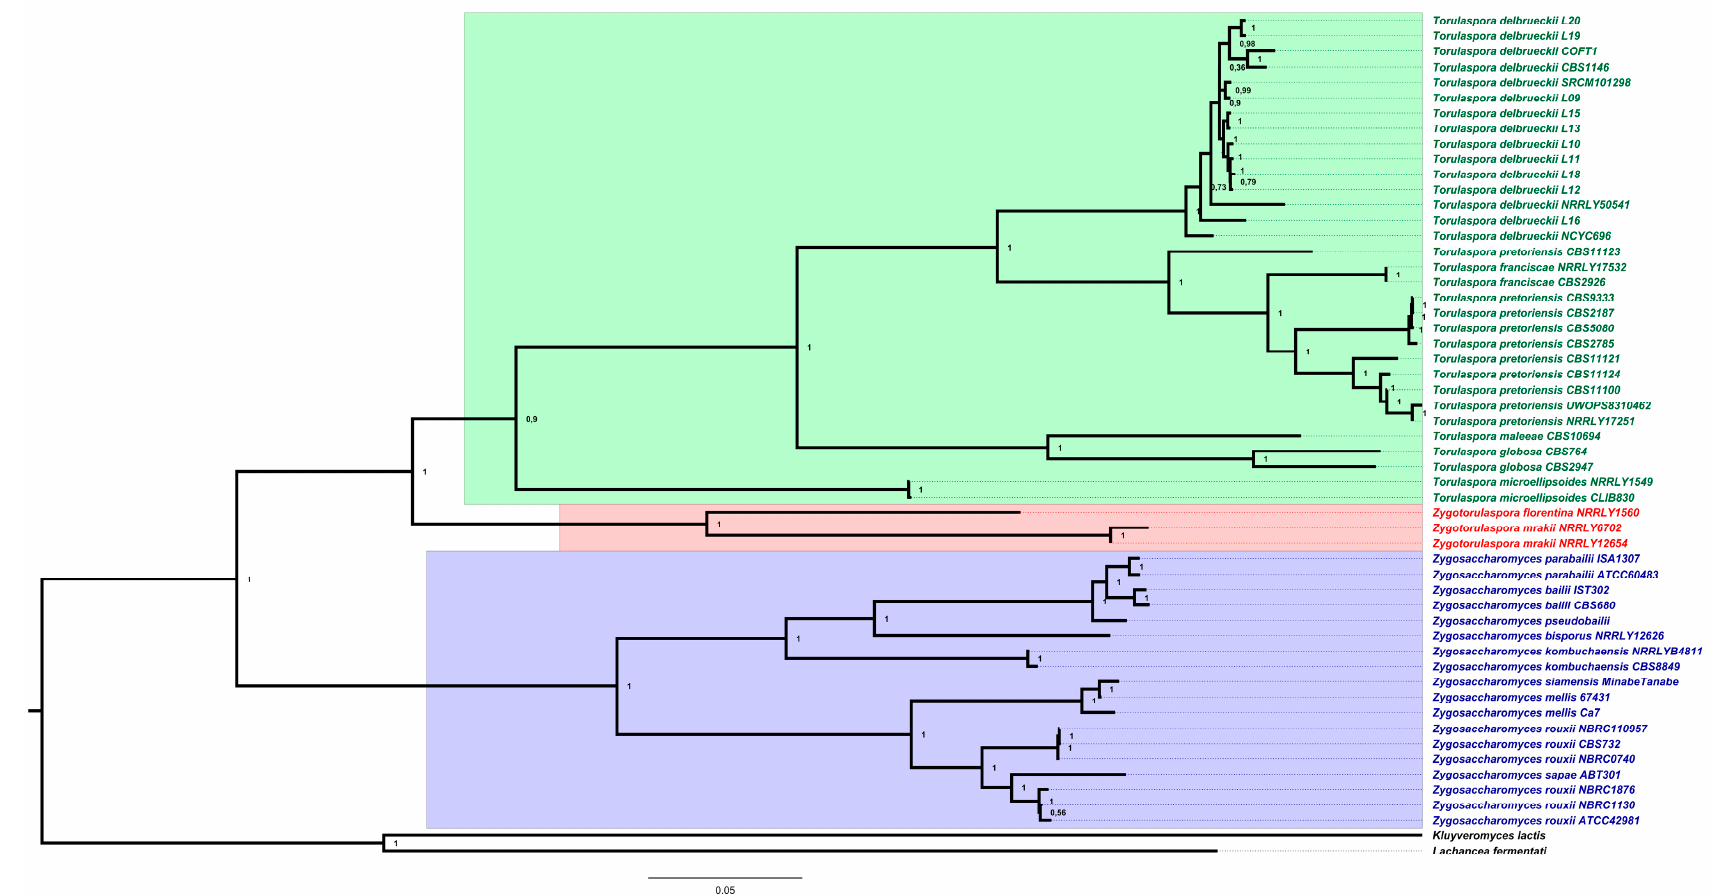
Figure 2. Phylogenetic placement of Torulaspora delbrueckii, showing the relationship of 15 strains with publicly available genomes, in relation to its closely related species, chosen from [25]. The phylogenetic reconstruction was obtained using the following parameters: maximum likelihood in IQ-TREE (http://www.iqtree.org, accessed on 28 July 2021), the model of amino acid evolution JTT (Jones–Taylor–Thornton), and four gamma-distributed rates. Homologues were detected for 3820 proteins across the proteome of the 55 fungal species/strains, collected from NCBI. The set of 3820 proteins was aligned and then concatenated for their use in the phylogenetic analysis. These proteins offer a clear high-resolution evolutionary view of the different species, as they are essential proteins beyond the specific biology of the different yeasts. Bootstrapping provided values of 100% for most